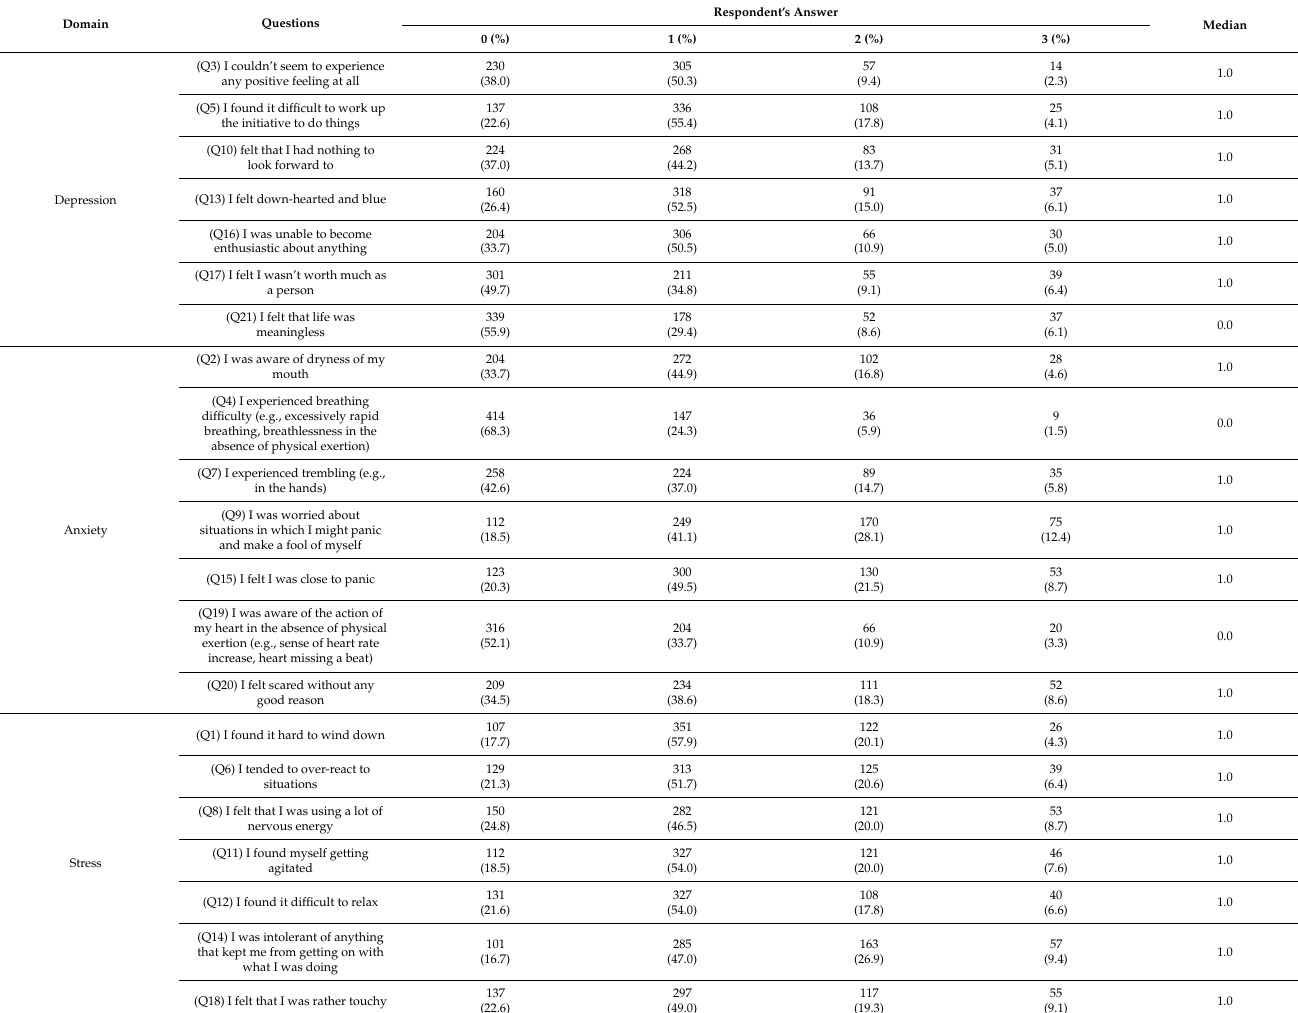
Table 3. Responses to the questionnaire on MH status (n =